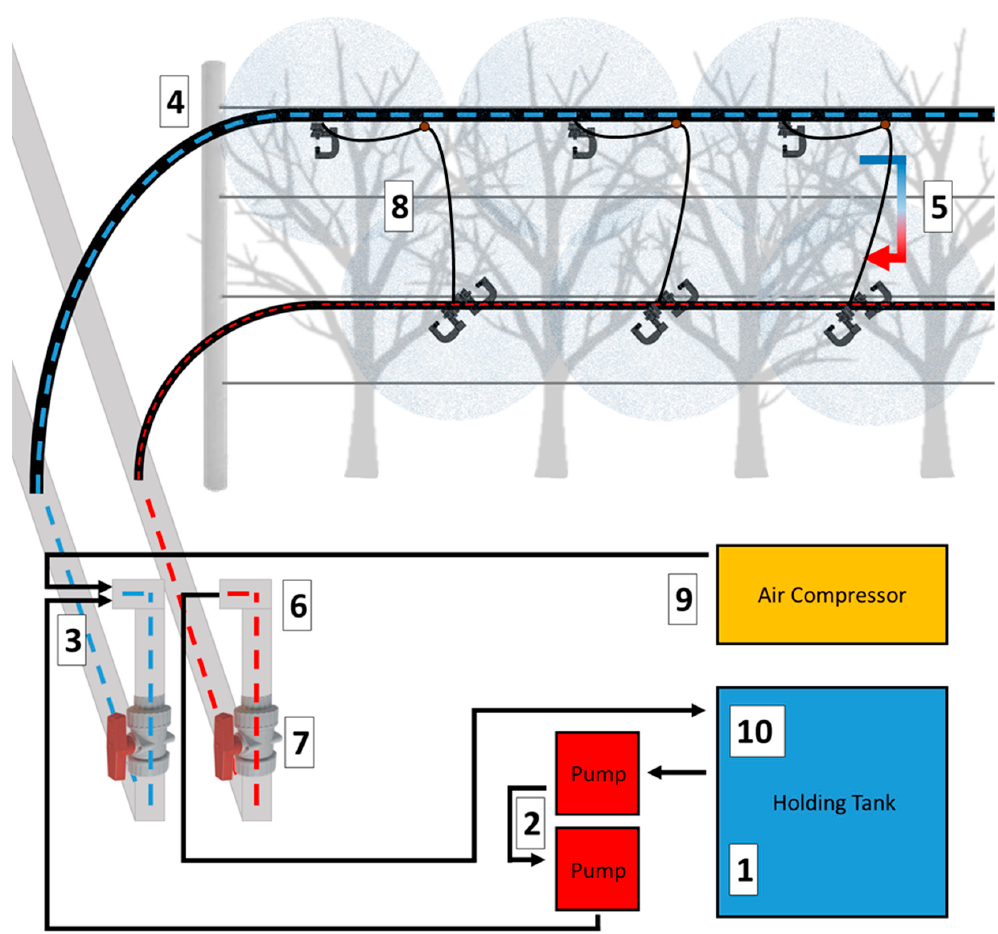
Figure 2. Schematic of Prototype Solid Set Canopy Delivery System.